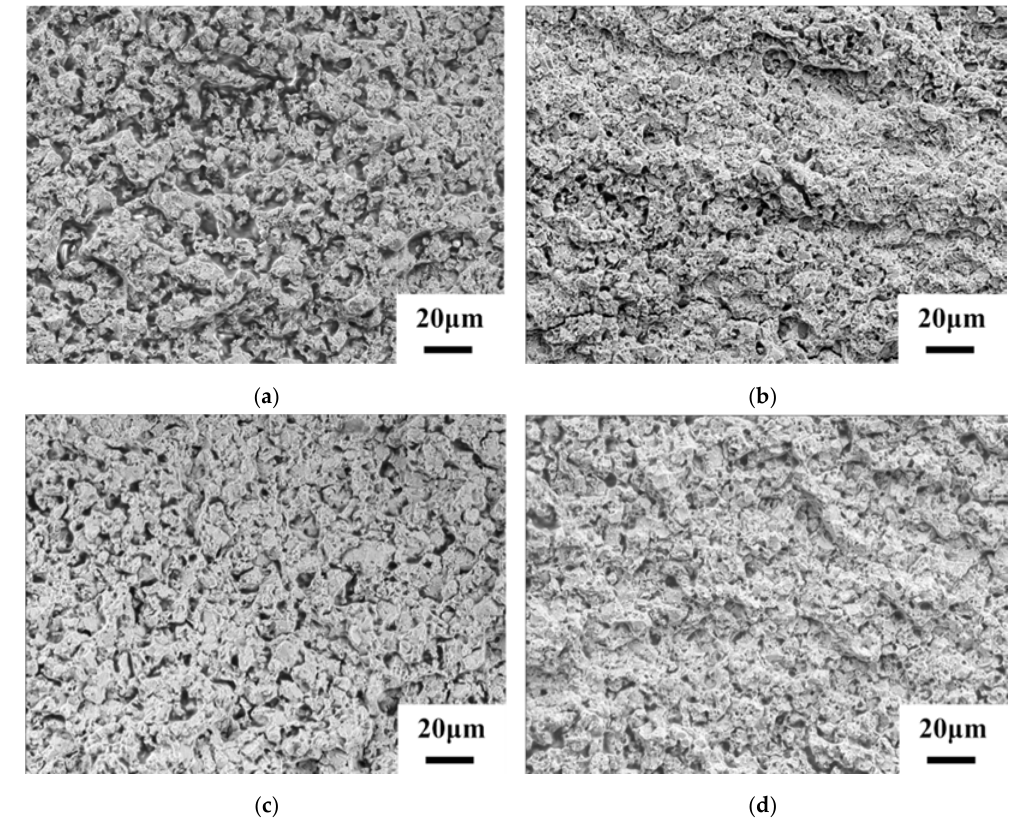
Figure 11. The fracture surfaces of the austempered specimens (1080 °C ‐ 30 min) with a salt ‐ bath temperature of 300 °C and different salt ‐ bath times: ( a ) 30 min, ( b ) 60 min, ( c ) 90 min, and ( d ) 120 min.